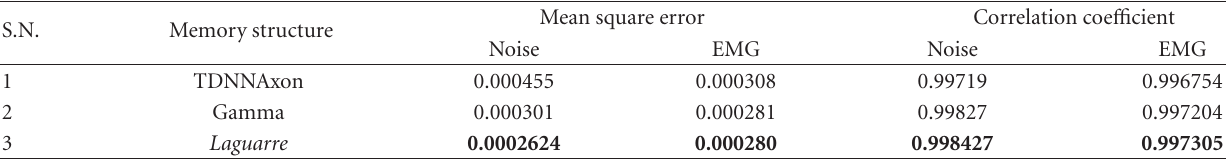
Table 6: Selection of memory structure for optimal performance of FTLRNN model.